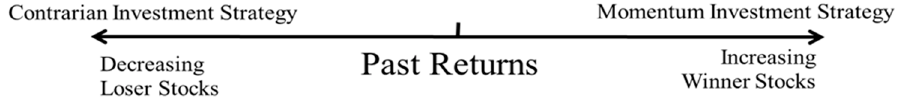
Figure 2. Contrarian–momentum investment strategy.